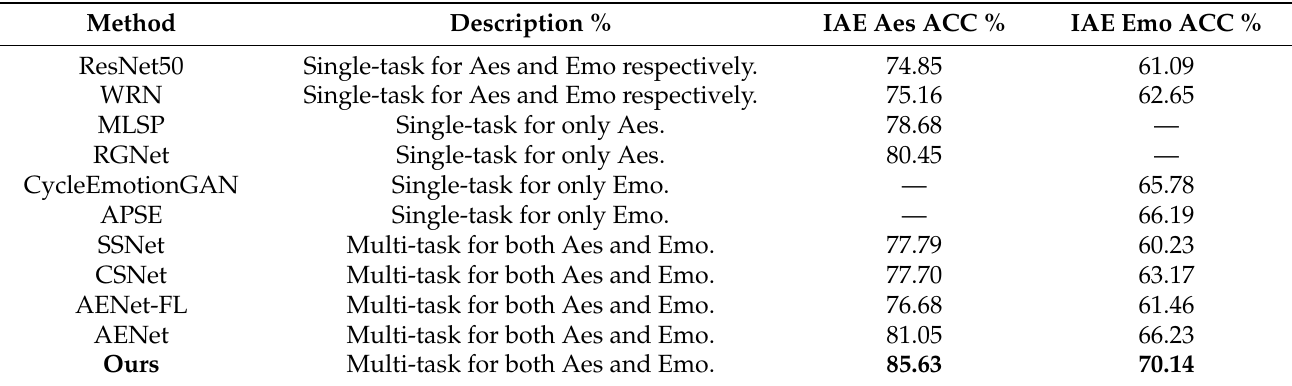
Table 1. Comparison on IAE for aesthetics assessment and emotion recognition, respectively (aesthetics is abbreviated as Aes, emotion as Emo, and accuracy as ACC).